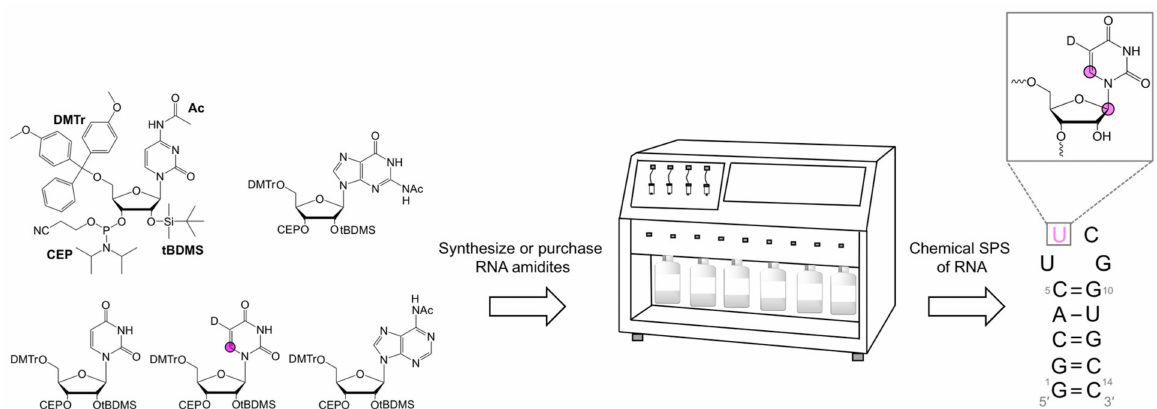
Figure 4. Chemical solid-phase synthesis of position-specifically-labeled RNA. Amidite building blocks (unlabeled and isotope-labeled) are used in an automated synthesizer to make pre-programmed RNA sequences with position-specific labels. Magenta nucleotides harbor stable isotope labels. Magenta circles and D represent 13 C and 2 H atoms, respectively. This example shows a [6- 13 C-5- 2 H]-UTP-labeled RNA at nucleotide